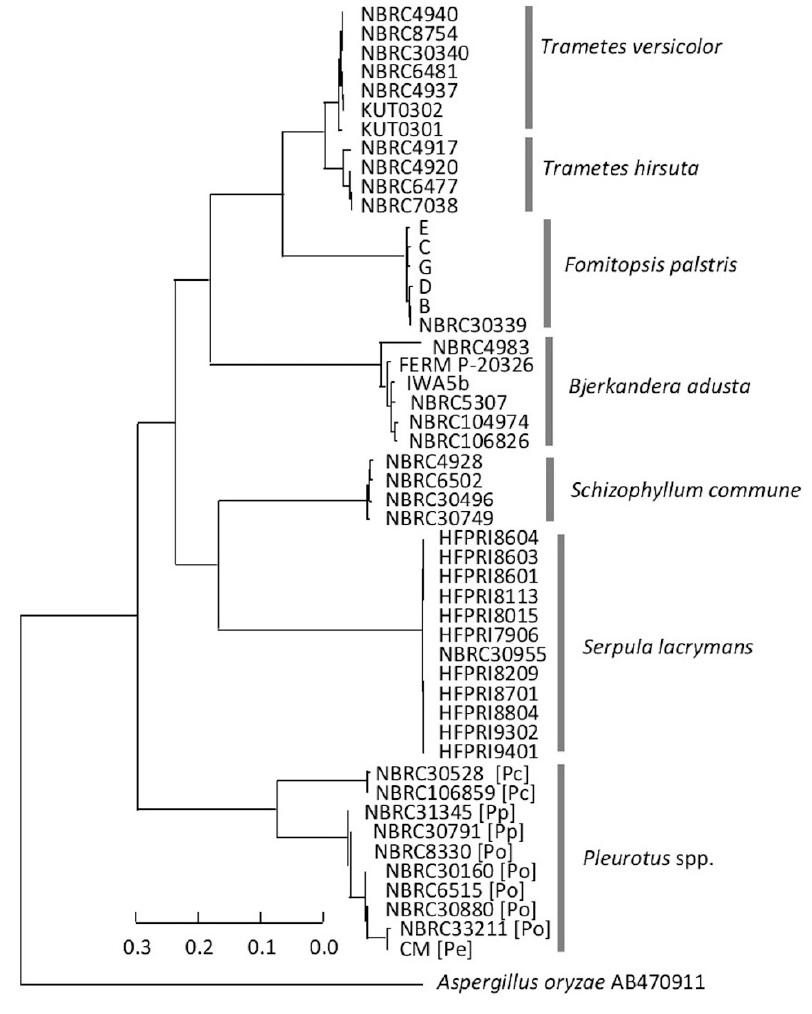
Figure 3. MSP dendrogram based on the nucleotide sequence of the internal transcribed spacer region from wood-rotting fungi. The sequence distances are given as a percent difference. Pp: P. citrinopileatus ; Po: P. ostreatus ; Pe: P. eryngii ; Pc: P. citrinopileatus ; Th: T. hirsuta ; Tv: T. versicolor. The dendrogram was created using Biotyper version 3.0 and distance units correspond with the relative similarity of MSPs.